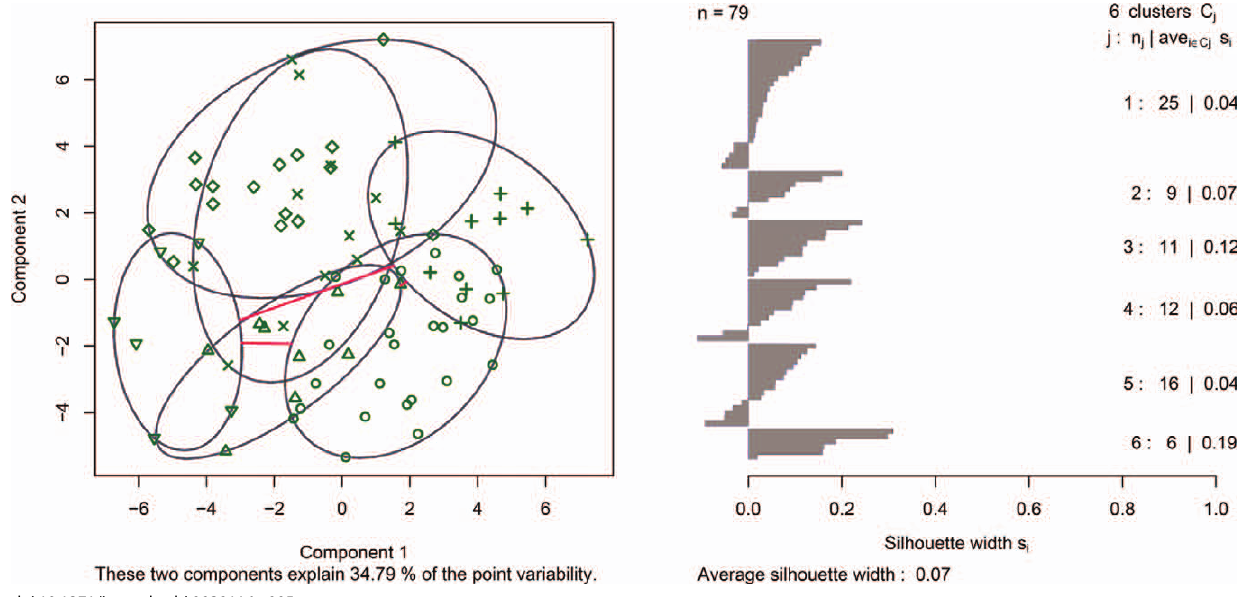
Figure 5. Two Views of the Partition Obtained by PAM Left, PC display; right, silhouette display. The ellipses plotted on the left are cluster-specific minimum volume ellipsoids for the data projected into the PCs plane. These should be regarded as two-dimensional representations of the robust approximate variance–covariance matrix for the projected clusters. The silhouette display comprises a single horizontal segment for each observation, ordered by clusters and by object-specific silhouette value within a cluster. Large average silhouette values for a cluster indicate good separation of most cluster members from members of other clusters; negative silhouette values for objects indicate instances of indecisiveness or error of the given partition.